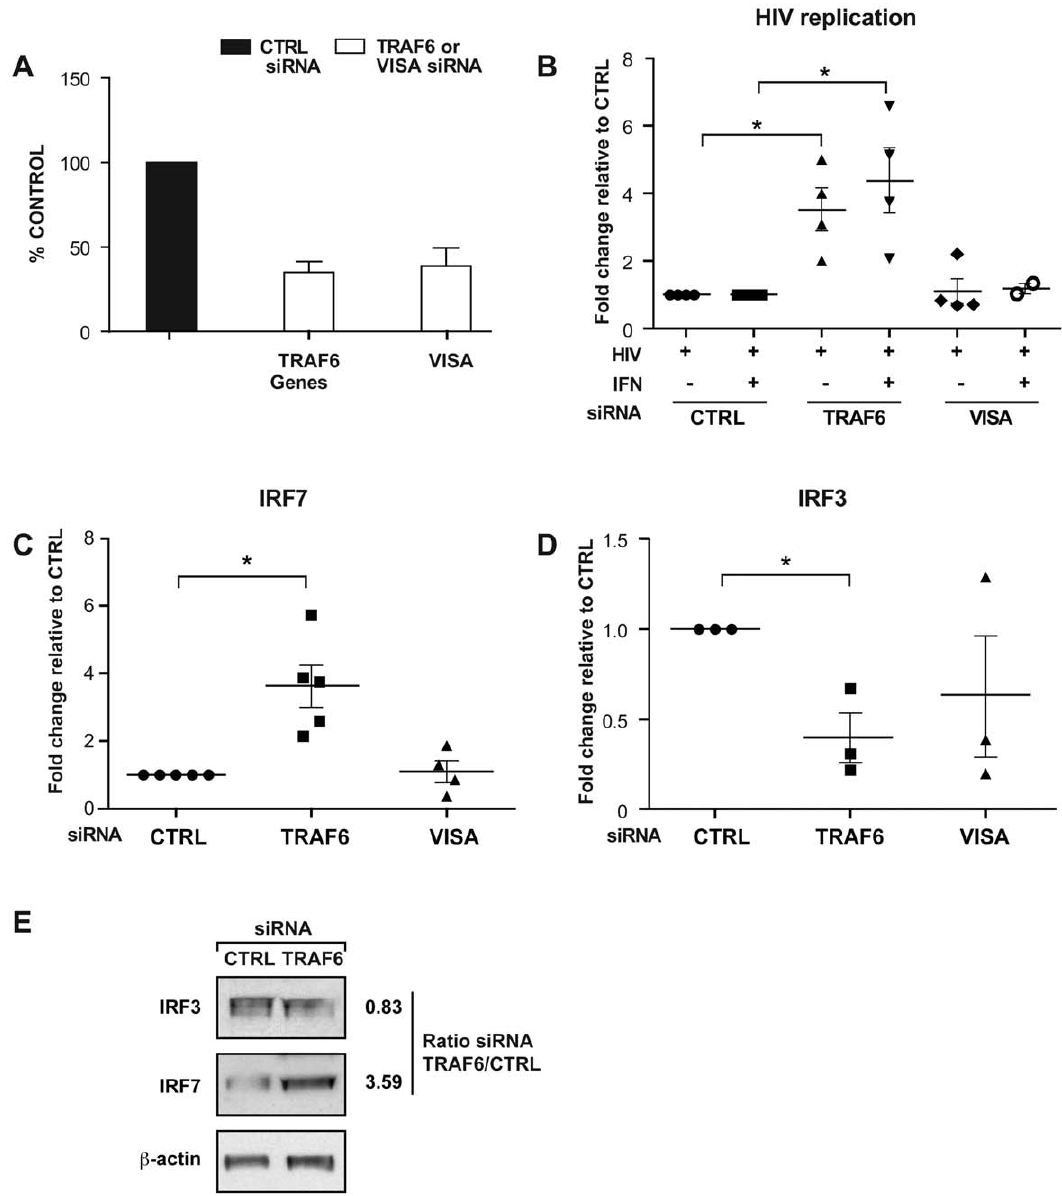
Figure 3. TRAF6 but not VISA controls the level of expression of IRF7 and HIV replication. Primary human macrophages were subjected to siRNA knockdown for TRAF6 and VISA . The concentration of siRNA used was 200 nM. A) Percentages of inhibition of TRAF6 and VISA in the presence of specific siRNA targeting both gene individually [n=3] compared to a control non-targeted siRNA [n=3]. Level of expression was measured by qRT- PCR B) Macrophages were all infected with HIV-1 with and without an IFN a 2 pretreatment, and treated with specific siRNA. The level of TAT spliced message measured 24 hours post-infection in TRAF6 and VISA conditions were compared to the negative control siRNA. C) Level of IRF7 and D) Level of IRF3 message expression in the absence of IFN a 2 when TRAF6 and VISA are repressed by siRNA compared to the negative control siRNA. The qRT- PCR results were normalized to the level of 18S. An * denotes a significant difference (P , 0.05, one sample t -test) compared to the negative control siRNA. Each symbol in a group represents one independent donor. E) Western blot for IRF3 and IRF7, 24 hours post-infection in macrophages with TRAF6 suppression compared to siRNA control. The densitometry of the bands was normalized to that of b -actin and shows a decrease in protein level of IRF3 and an increase of IRF7. The ratio is shown next to the respective panels. Results shown are representative of 3 independent experiments.